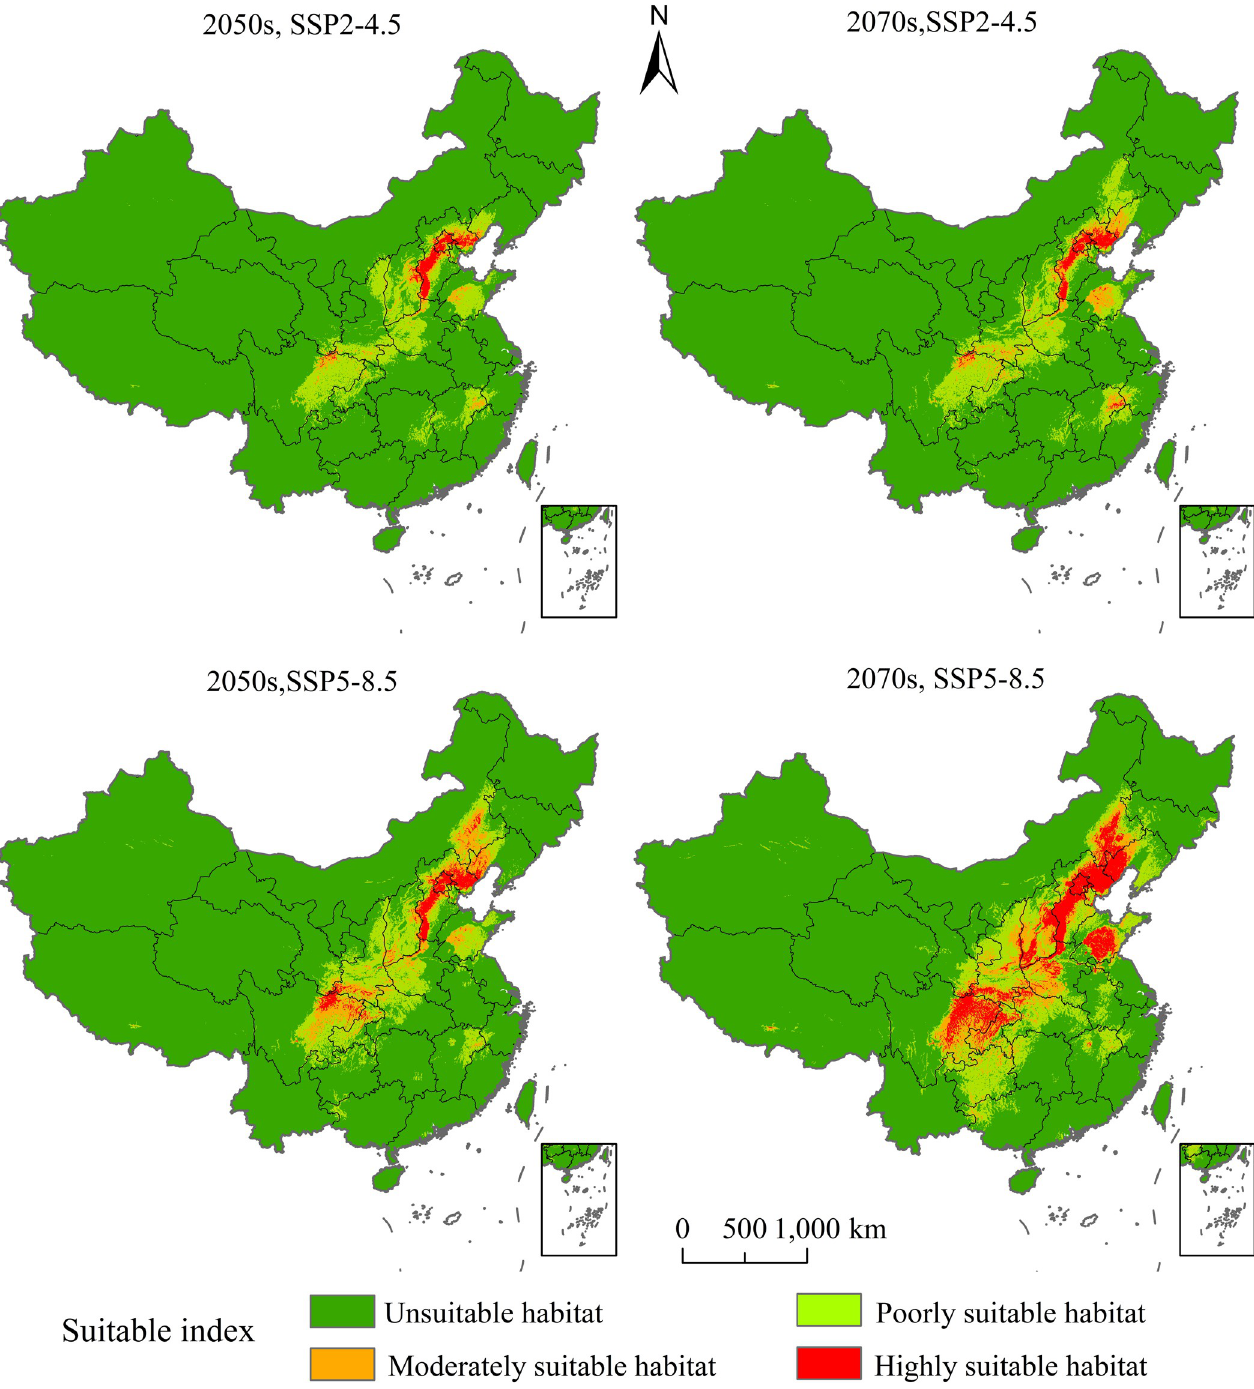
Fig 8. Potential geographical distribution of P . tatarinowii under future climate change scenarios. This map was made in ArcGIS 10.2 using the resulting rasters produced by MaxEnt. The boundary was obtained from the Ministry of Natural Resources of the People’s Republic of China (http://bzdt.ch.mnr.gov.cn/ index.html), Map review number: